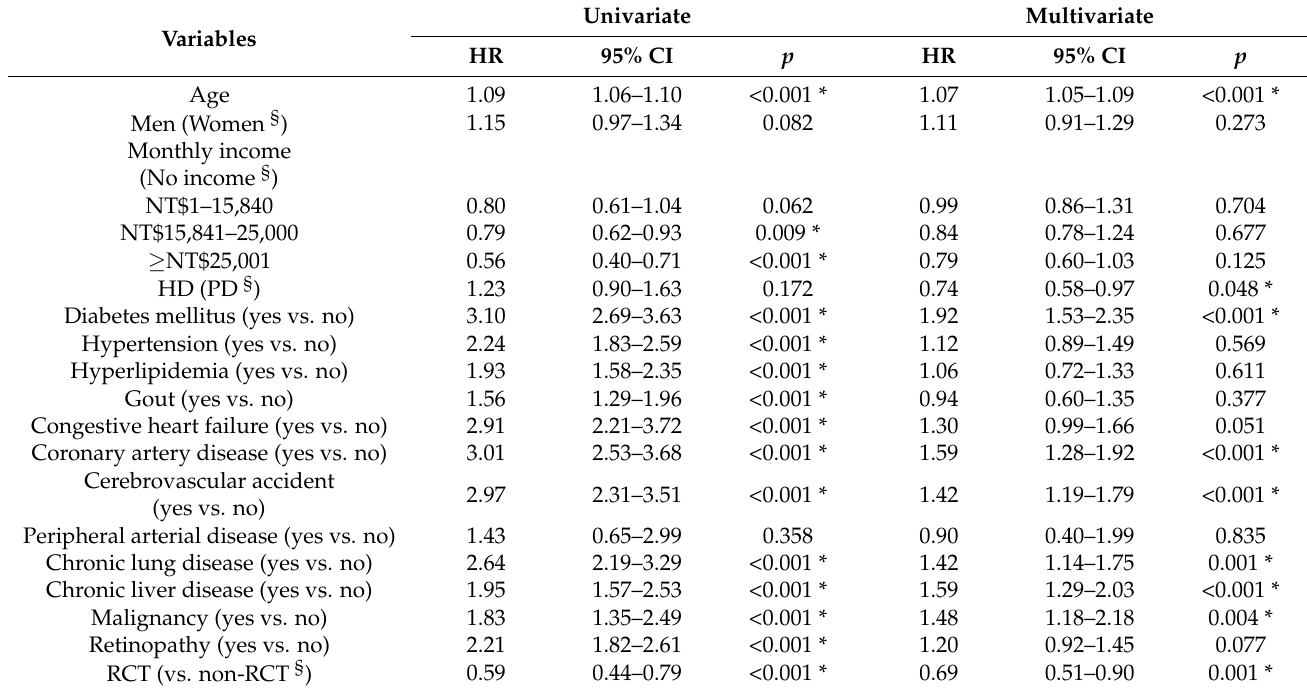
Table 3. Hazard ratios of risk of death among dialysis patients with RCT and without RCT.